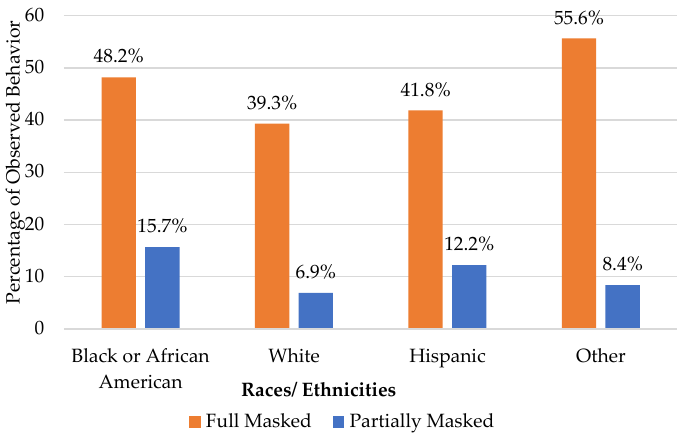
Figure 2. Overall masking behaviors by race/ethnicity. Figure 3 highlights the differences in masking behaviors seen at the various establish- ments based on signage in a particular location. The results indicate that, as compared to establishments with no mask-related signage, individuals in establishments with “Mask- positive” signage had an increase in the odds of mask wearing. Conversely, individuals in locations with “Mask-negative” signage had a decrease in the odds of being fully masked as compared to those in establishments with no mask-related signage.